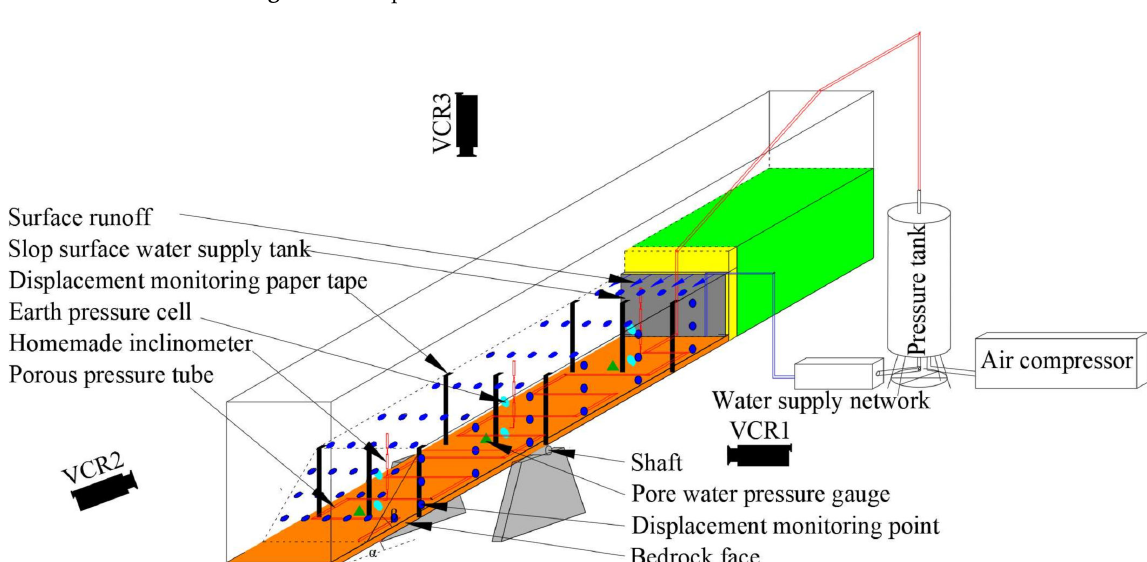
Figure 6. Schematic of the